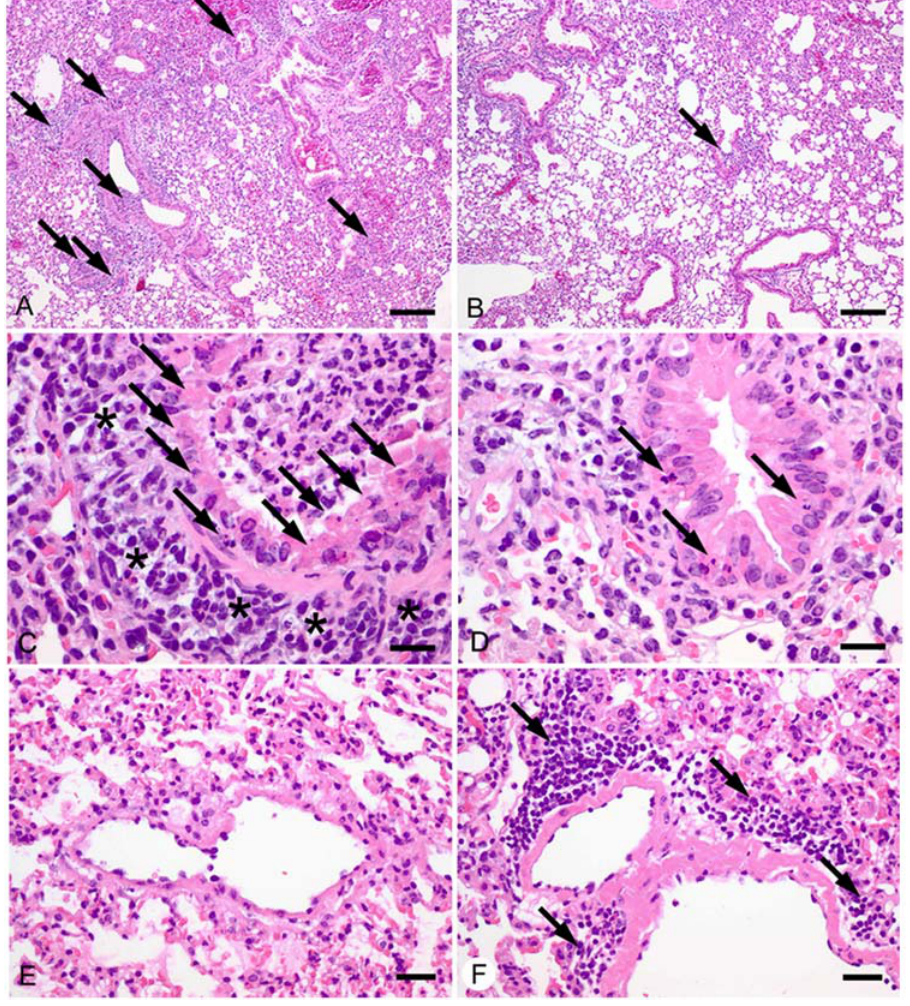
Figure 8. Severe damage of bronchial epithelia occurs in DBA/2J compared to C57BL/6J mice. DBA/2J (A, C, E) and C57BL/6J mice (B, D, F) were infected intra-nasally with 2 6 10 3 FFU of PR8 virus. Lung sections were stained with hematoxylin and eosin. A, B: Two days after infection, the lungs of DBA/2J mice (A) were more consolidated with higher numbers of plugged airways (arrows) than C57BL/6J mice (B). C, D: The bronchioli and bronchi of DBA/2J mice (C) were plugged with degenerate bronchial epithelial cells and neutrophils with higher degrees of degeneration, necrosis and loss of epithelial cells (arrows) two days after infection. In addition, the airways were surrounded by larger numbers of neutrophils and macrophages (asterisks). Airways of C57BL/6J mice (D) showed less damage with little or no plugging of airways. At that time point, the lungs of both strains had few infiltrations with lymphocytes. E, F: Four days after infection, virtually no extravasations of lymphocytes were detected in DBA/2J mice (E) whereas marked perivascular lymphocytic infiltrations (arrows) were observed in the pulmonary interstitium of C57BL/6J mice (F). Bars = 250 m m (A, B), 25 m m (C, D) and 50 m m (E, F).